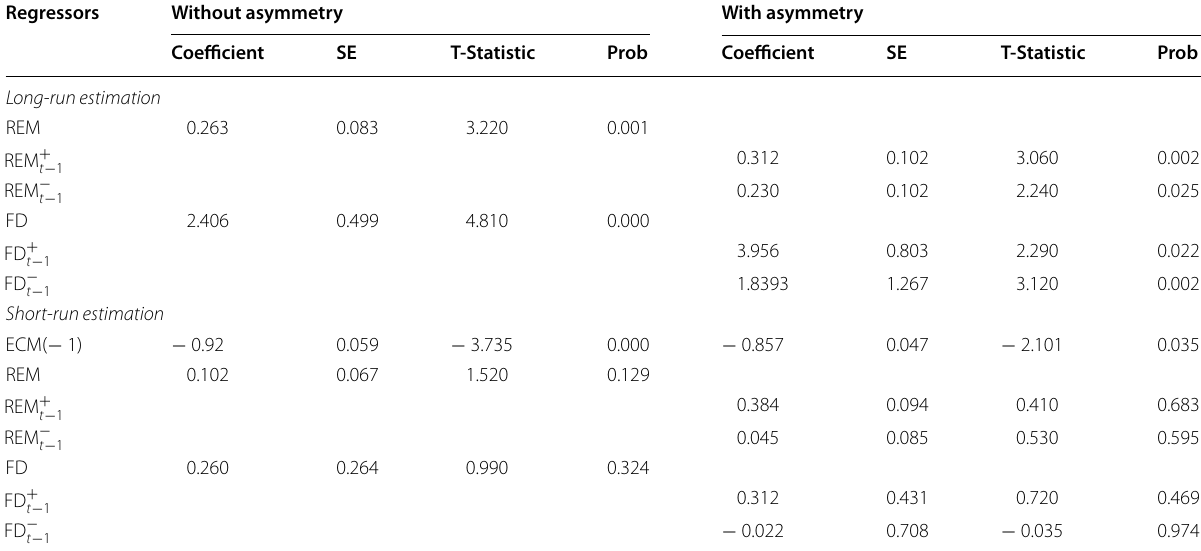
Table 3 Panel regression outcomes. Source : Authors Collation with Stata 15 Regressors Without asymmetry Coefficient Long-run estimation